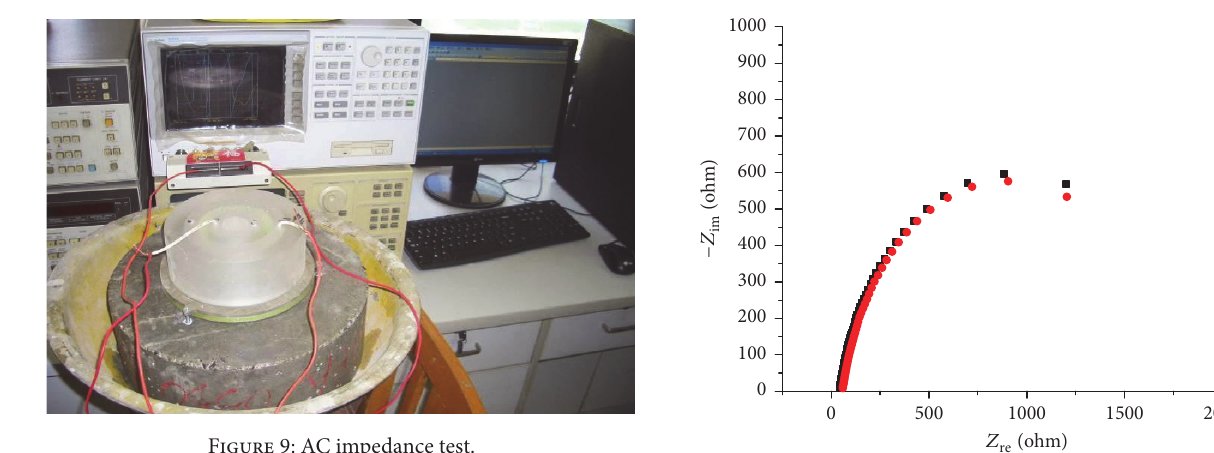
Figure 9: AC impedance test.